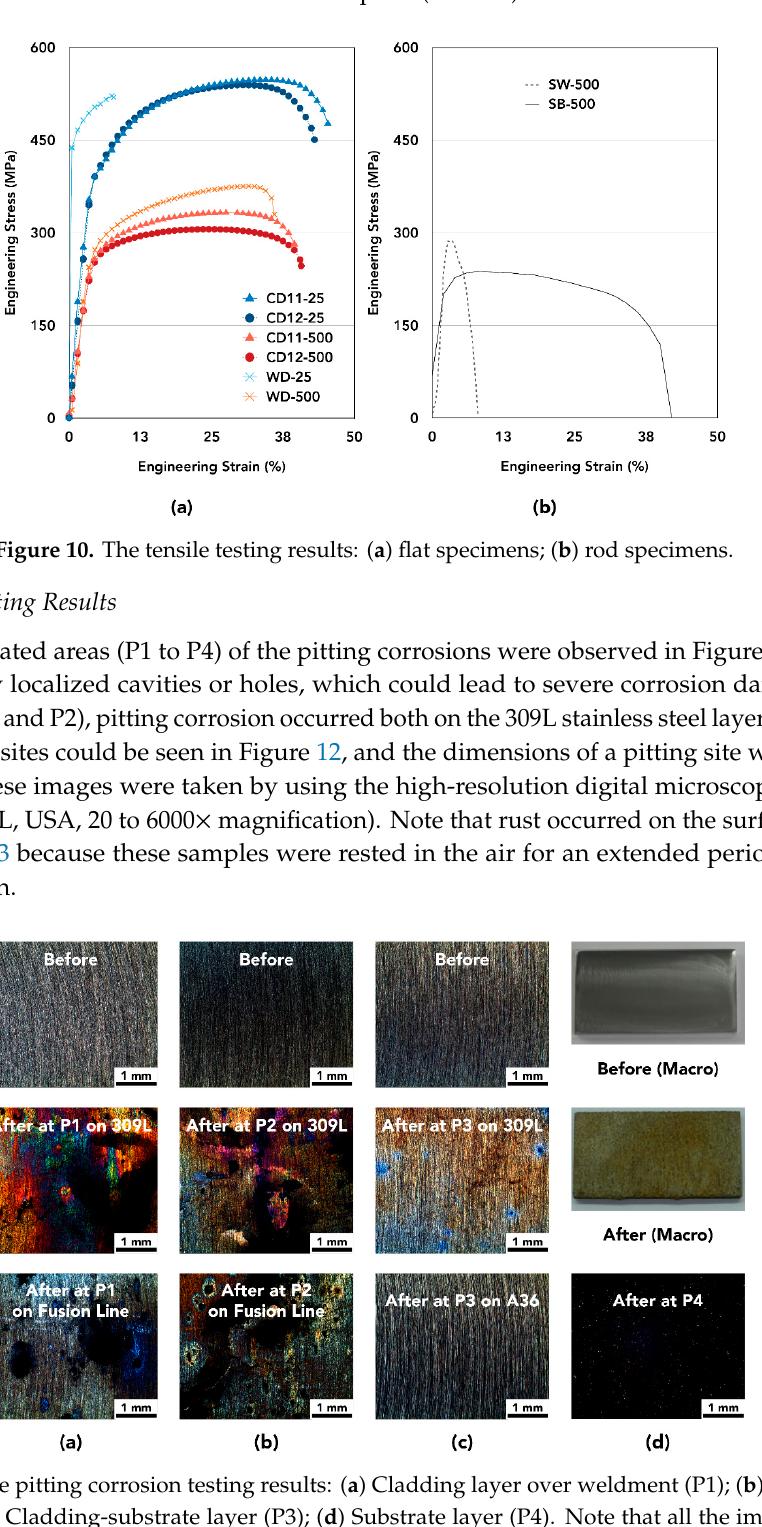
Figure 12. The pitting locations sampled from the P1 and P2 areas.